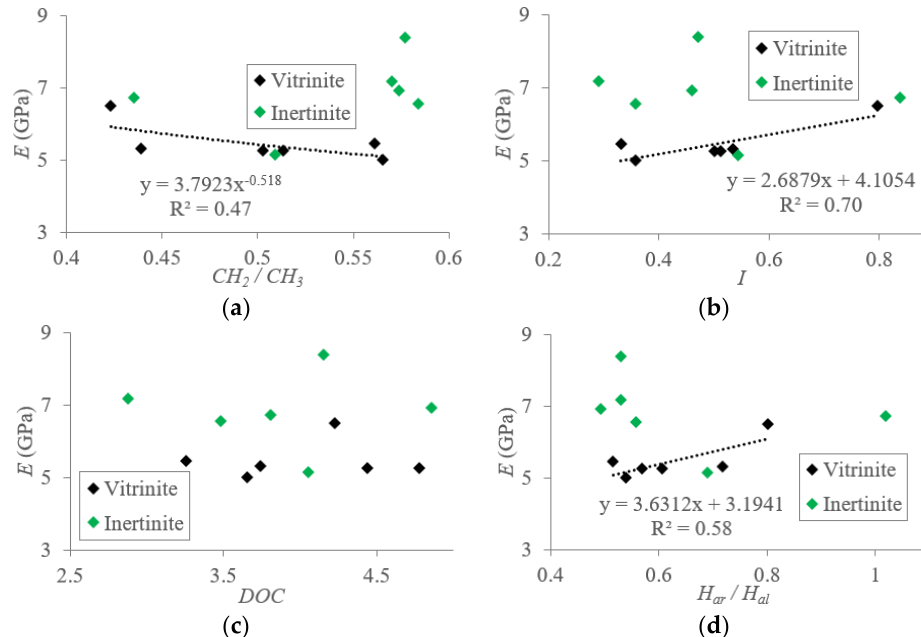
Figure 16. Relationship between FTIR parameters (( a – d ) are the CH 2 / CH 3 , I , DOC , and H ar / H al , respectively) and E. (Note: Here, E is the mean value for each sample).